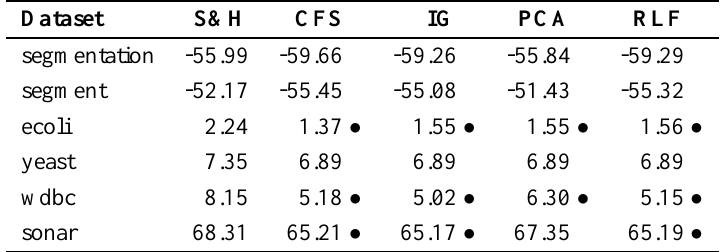
Table 7. Log-likelihood comparisons of feature-reduced simple EM